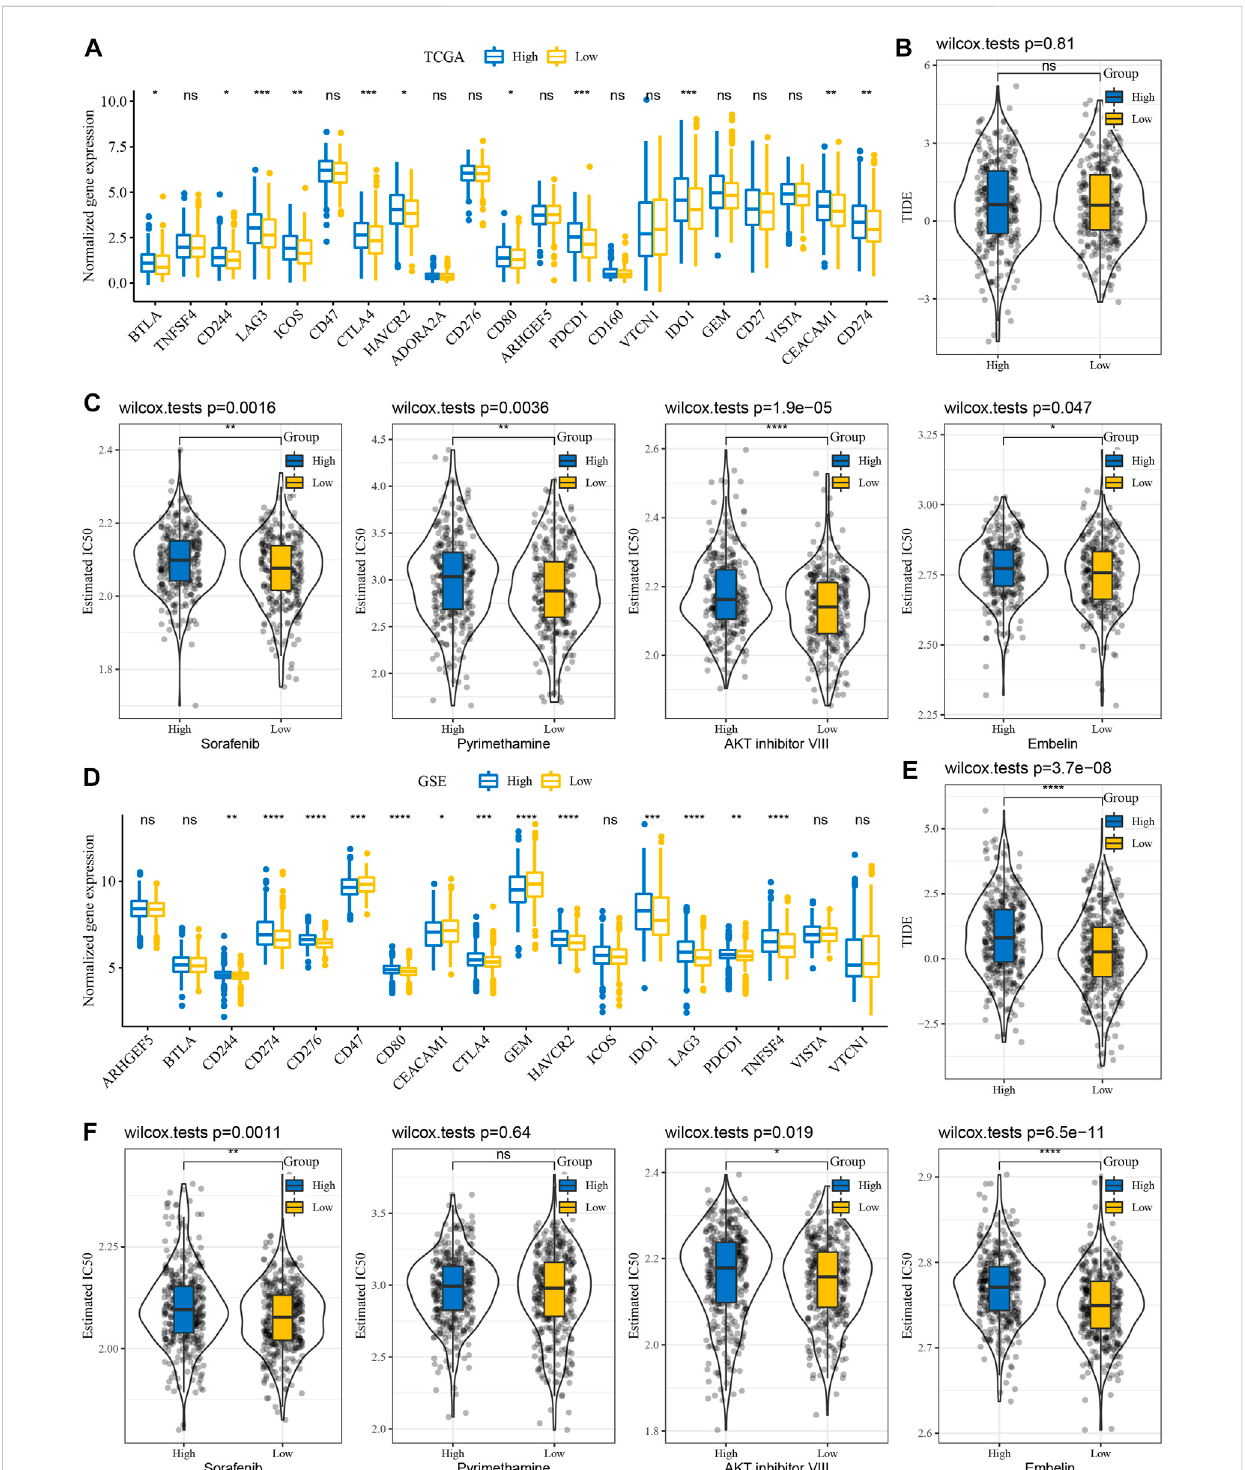
FIGURE 6 Immunotherapy/chemotherapy sensitivity analysis. (A) Immunological checkpoint of differential expression between different groups in TCGA cohort. (B) Difference in TIDE analysis results among different groups in TCGA queue. (C) Box plots of the estimated IC 50 for sorafenib, pyrimethamine, Akt inhibitor VIII, and embelin in TCGA cohort. (D) Differentially expressed immune checkpoints between different subgroups in the GSE cohort. (E) Differences in TIDE analysis results among different groups in GSE queues. (F) Box plots of the estimated IC 50 for sorafenib, pyrimethamine, Akt inhibitor VIII, and embelin in